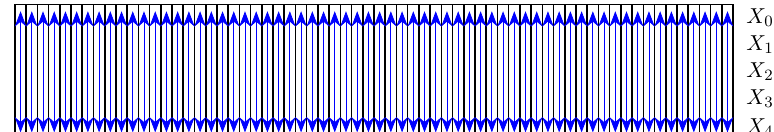
Figure 5: The substitution layer p S